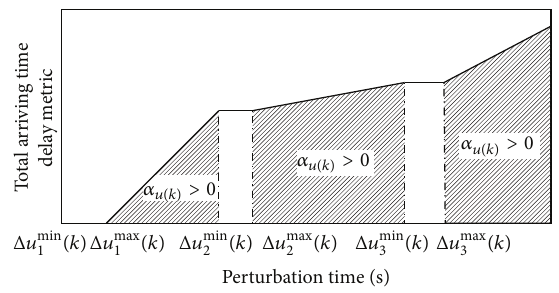
Figure 13: Total flight delay metric for a departure-time perturba-